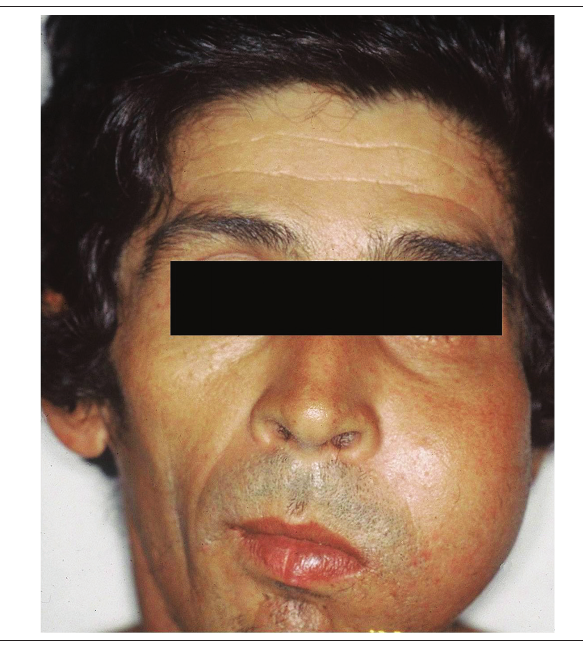
figurE 1 − Extraoral asymmetry involving the left side of maxilla